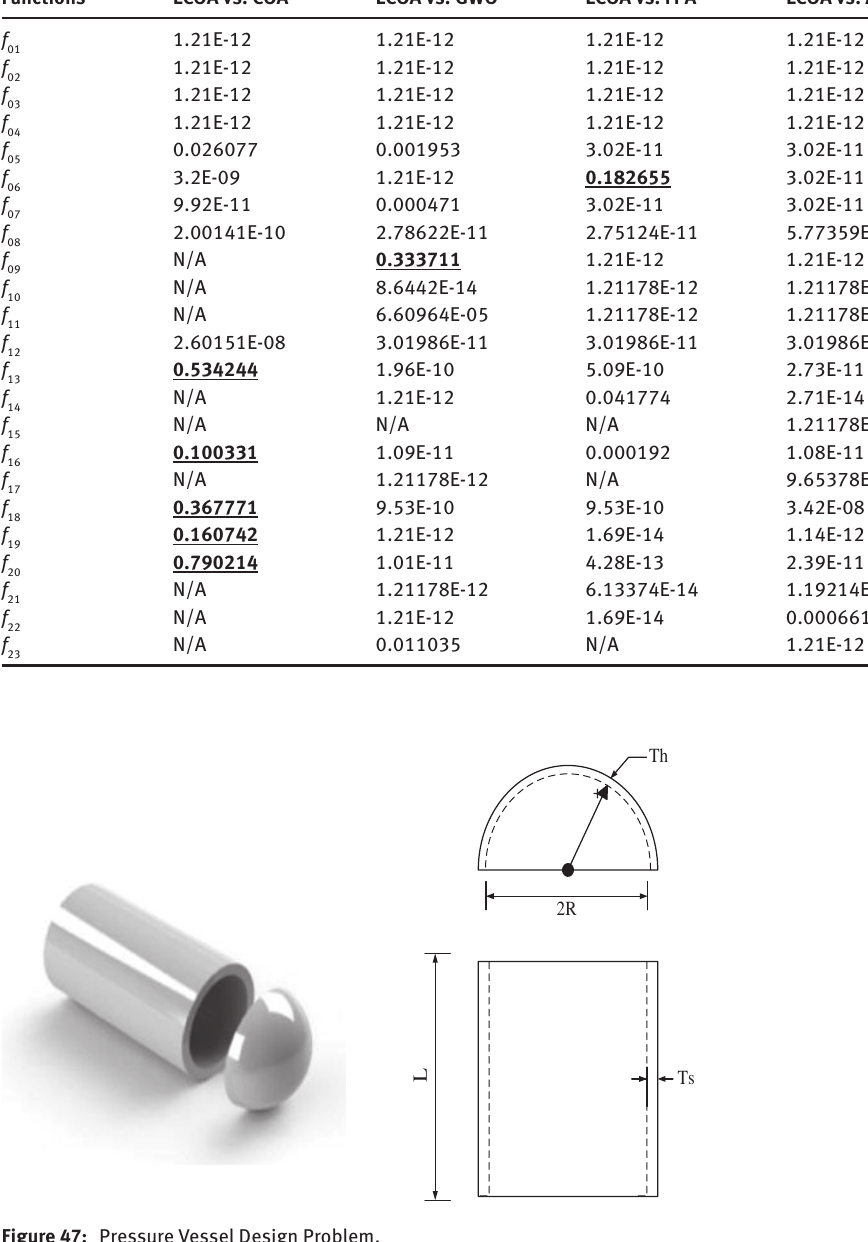
Figure 47: Pressure Vessel Design